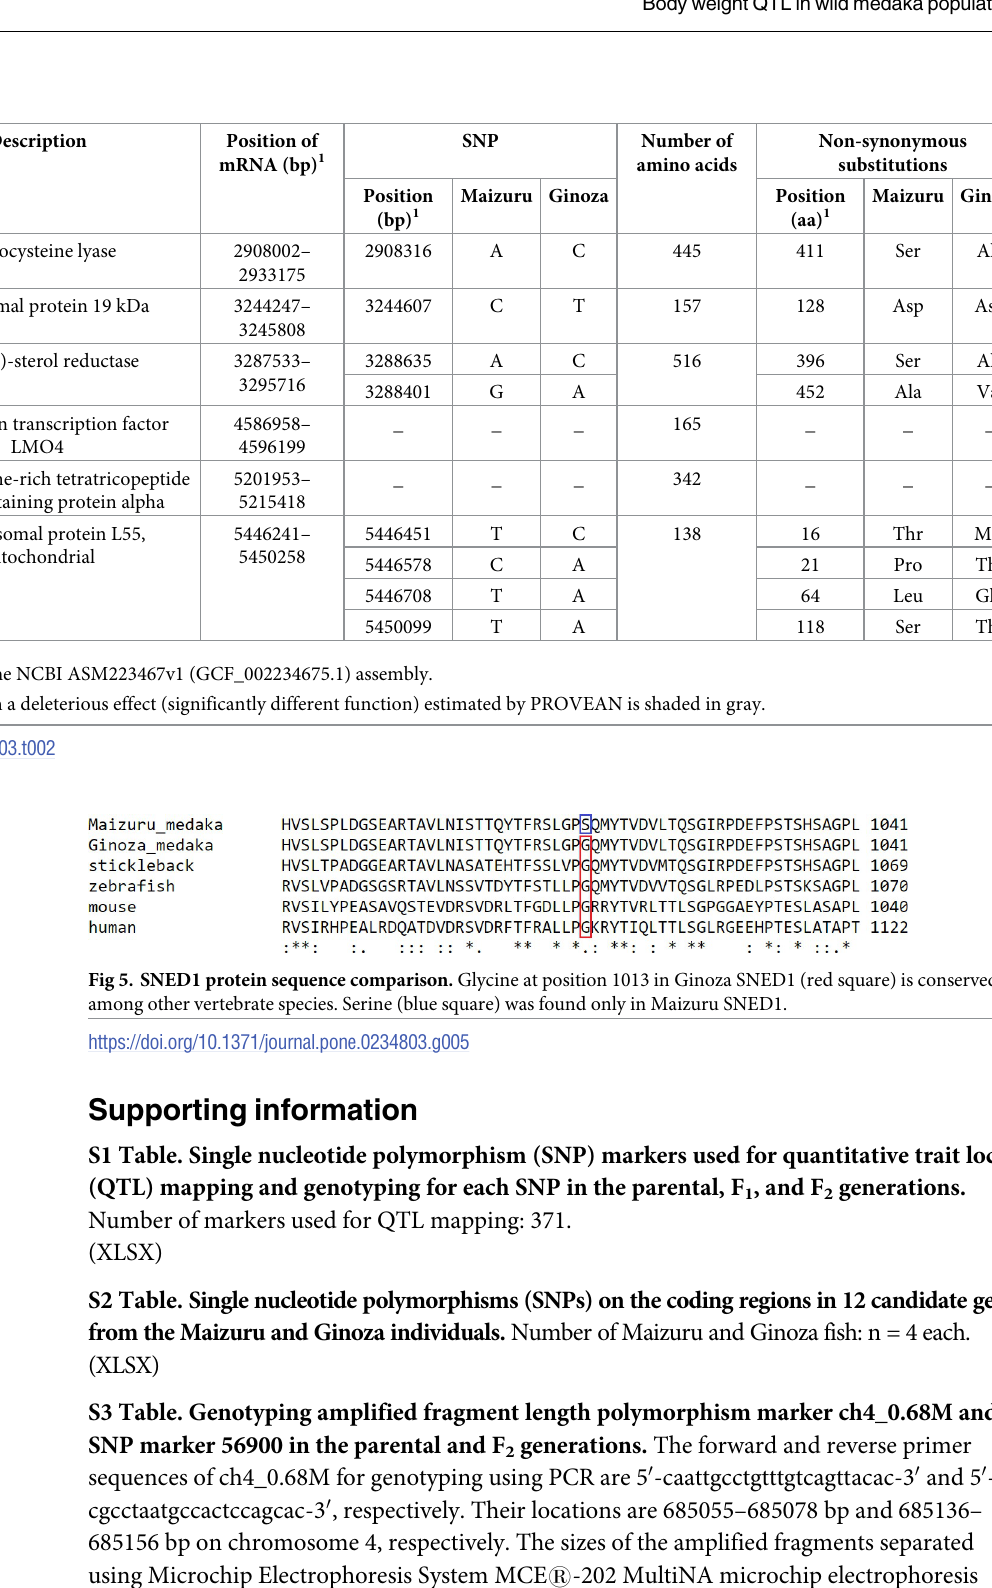
S3 Table. Genotyping amplified fragment length polymorphism marker ch4_0.68M and SNP marker 56900 in the parental and F generations. The forward and reverse primer 2